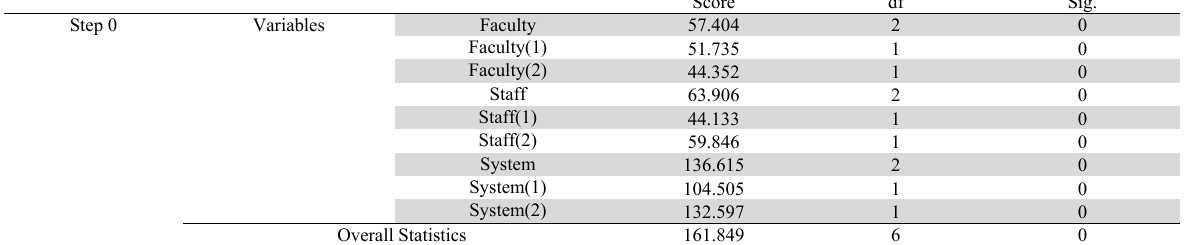
Variables not in the Equation